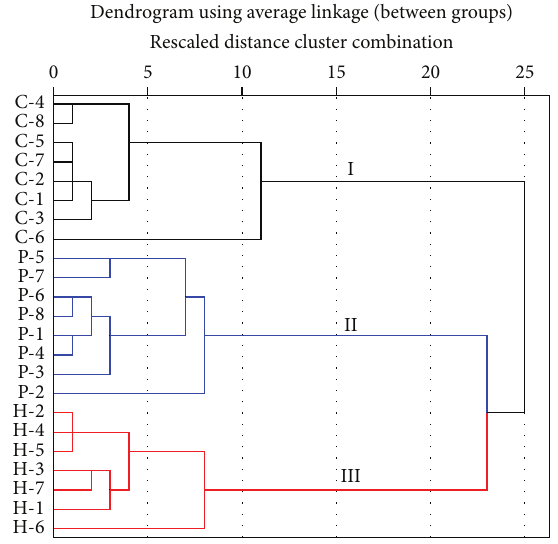
Figure 9: Dendrogram resulting from hierarchical cluster